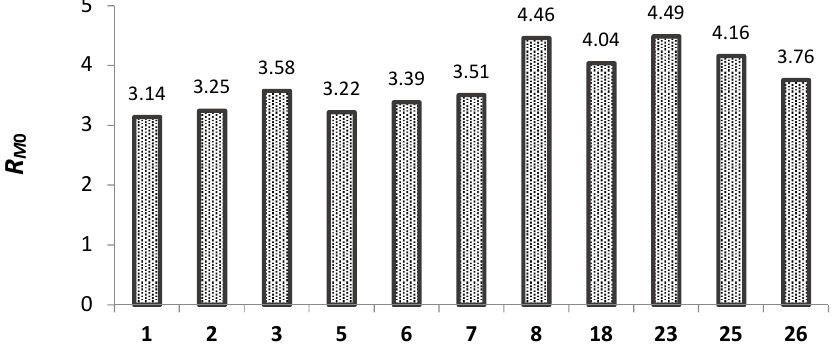
Figure 6. Lipophilicity parameters evaluated using R-TLC: R M 0 values for compounds 1 – 3 , 5 – 8 , 18 , 23 , 25 and 26 .